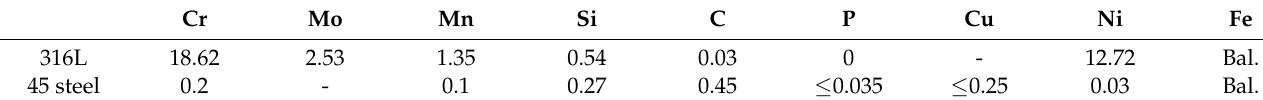
Table 1. Chemical composition of 316L and substrate (wt%).